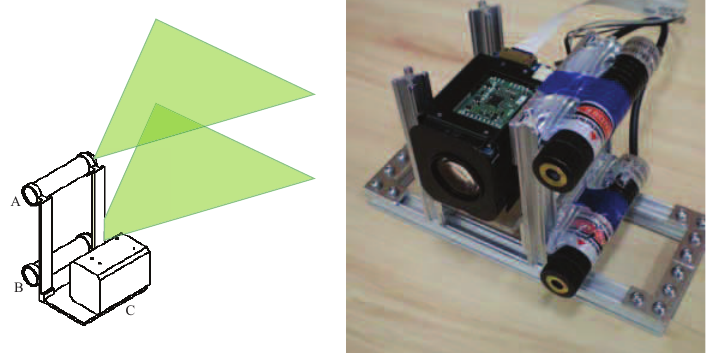
Figure 1. Design of the prototype sensor on the left and the actual prototype on the right.